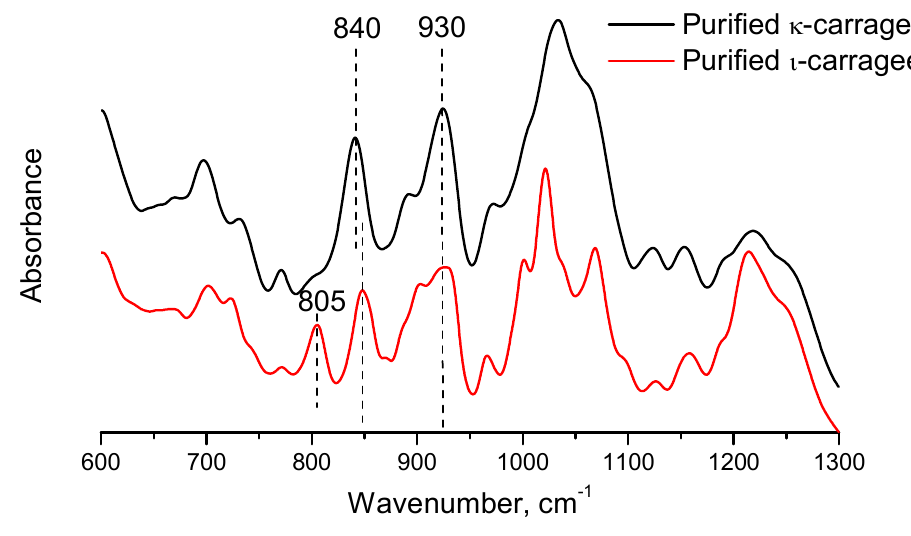
Figure 2. FTIR-ATR spectra of purified κ- and ι-carrageenan